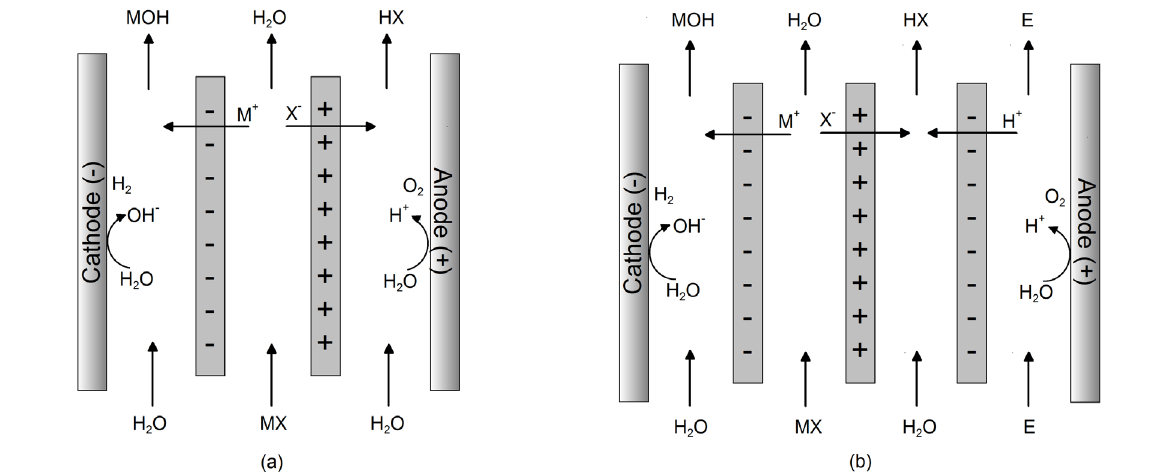
Figure 2: Schematic representation of electro-electrodialysis